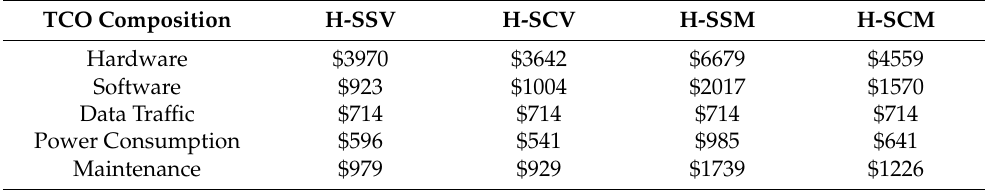
Table 7. Cost comparison of different intelligence allocations. All costs are listed in USD. TCO